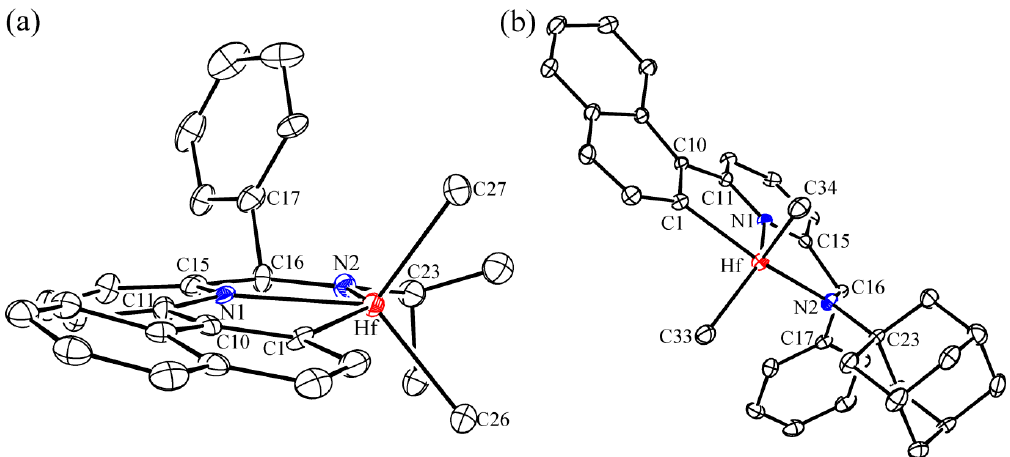
Figure 3. Thermal ellipsoid plot (30% probability level) of 22 (a) and 25 (b). Hydrogen atoms are omitted for clarity. Selected bond distances (Å) and angles ( ◦ ) in 22 (a): Hf-N(1), 2.296(10); Hf-N(2), 2.065(11); Hf-C(1), 2.285(12); Hf-C(26), 2.203(14); Hf-C(27), 2.223(14); C(27)-Hf-N(1), 122.7(5);